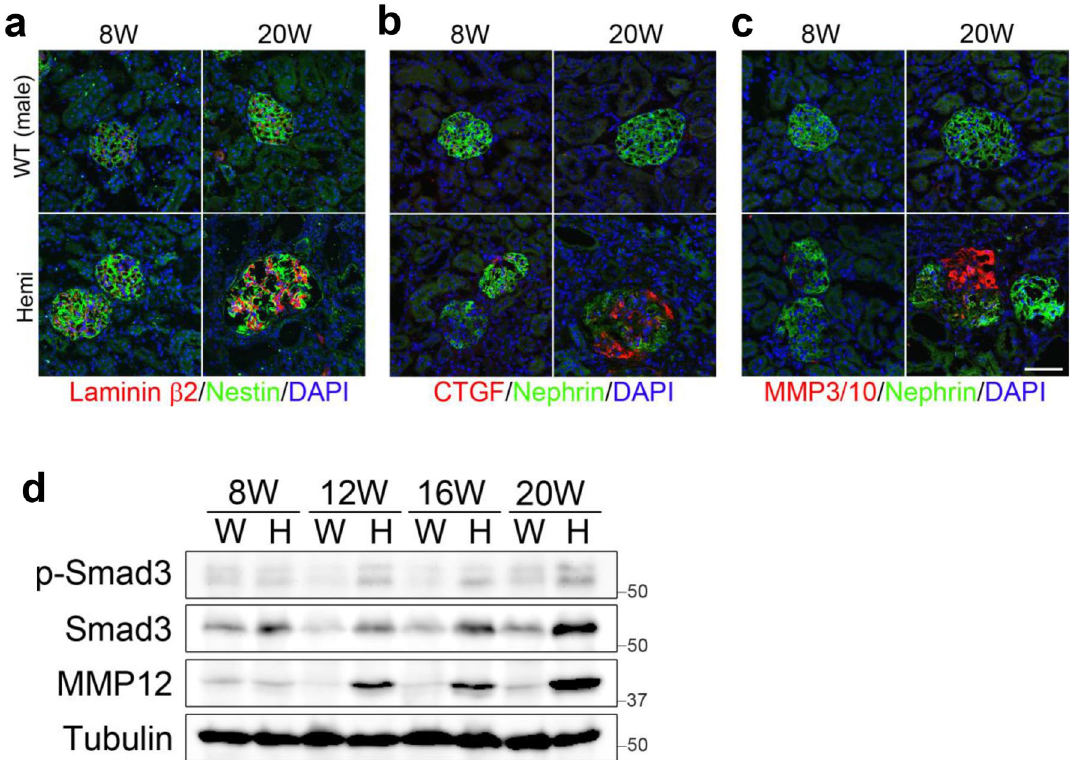
Figure 5. Immunostaining and Western blotting of the GBM in Col4 α 5 deficient kidneys. (a–c) Immunofluorescence analyses of rat kidney sections with antibodies against (a) : Laminin β2 (red), Nestin (green; glomeruli); (b) : CTGF (red), Nephrin (green); (c) : MMP3/10 (red), Nephrin (green); and DAPI (blue; nuclei) in wildtype (WT) and Col4α5 mutant (Hemi) male rats at 8 weeks (left) and 20 weeks (right) of age. Scale bars , 50 µm. (d) Detection of phospho- and total Smad3, and MMP12 by Western blot analyses of the kidneys in wildtype (W) and Col4α5 mutant (H) male rats from 8, 12, 16, to 20 weeks of age. Tubulin was evaluated as an internal